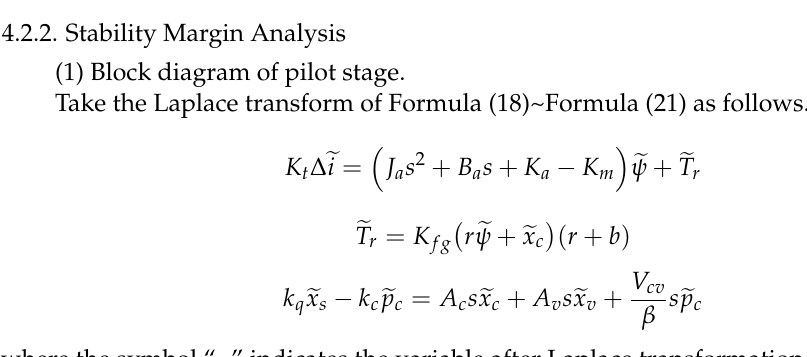
Figure 18. Output pressure with different input signal: ( a ) step input signal, ( b ) ramp input signal. It can be seen that, compared with the prototype system, the output pressure of the PSVS does not oscillate under either the step signal or the ramp signal input, which means that the self-excited oscillation of PSVS is effectively eliminated.